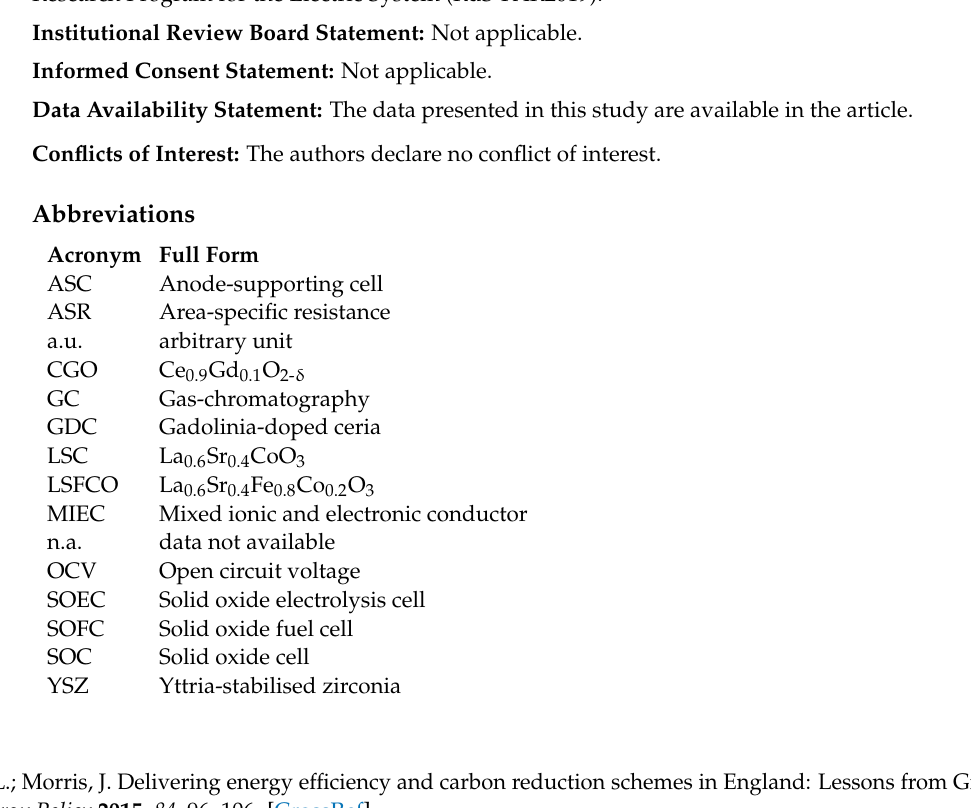
Figure S6. Carbon balance of gas achieved under practical conditions. The gas-chromatographic data were treated ac-cordingly to Equation (1). Figure S7. SEM analysis of spent cell highlighting the interface regions (a) and the magnification of cathode microstruc-ture (b). Figure S8. XRD spectrum of functional layer on the spent cell. Figure S9. EDX analysis of spent functional